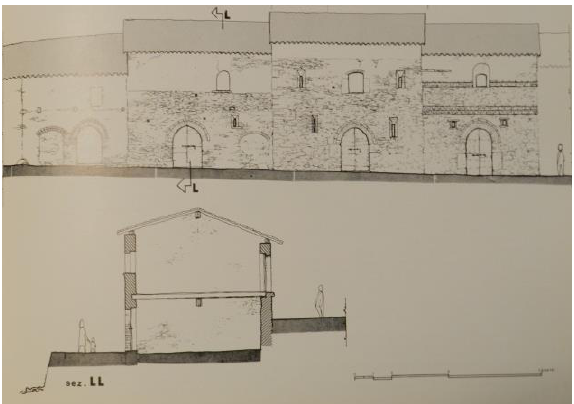
Figure 4. Elevation and section of some building cells (after Viglino Davico,